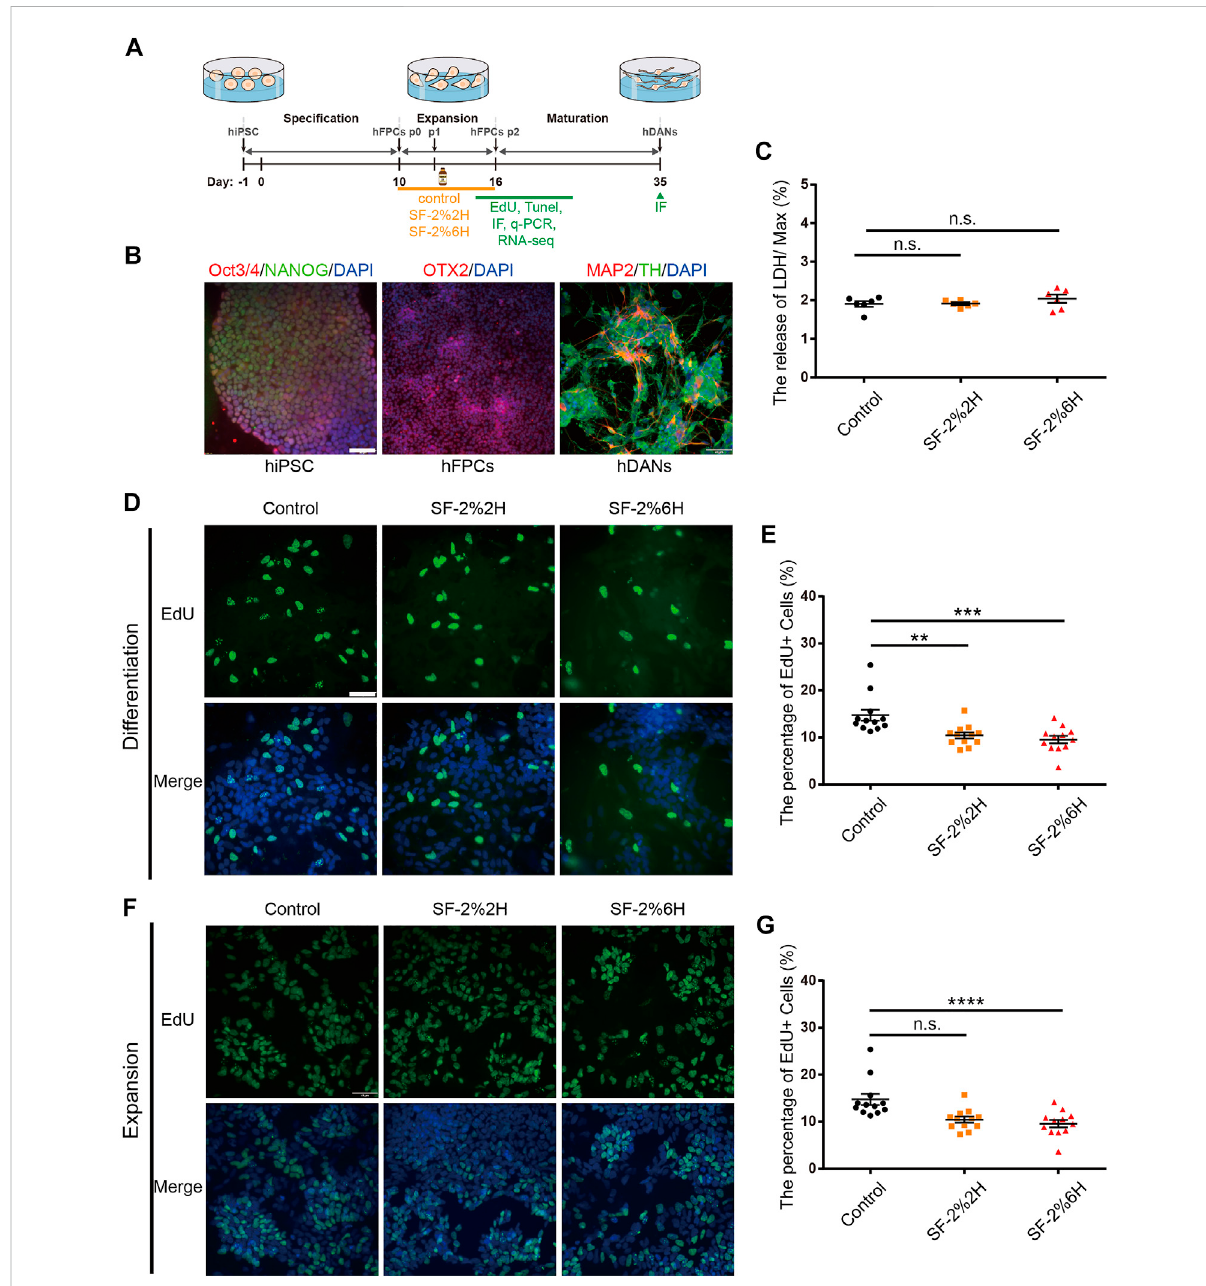
FIGURE 1 Sevo fl urane decreased the proliferation of monolayer hFPCs. (A) Schematic representation of the experimental pipeline used in the differentiation process of hiPSCs-derived hDANs. (B) Con fi rmation of the expressions of hiPSCs, hiPSCs-derived hFPCs, and hFPCs-derived hDANs. Immunolabeling of Oct4 (red), Nanog (green) and DAPI (blue) in hiPSCs; OTX2 (red) in hiPSCs-derived hFPCs on D10. hFPCs were further differentiated into hDANs, as illustrated using MAP2 (red) and TH (green) on D35. (C) LDH relative release of hFPCs in the control, SF-2%2H and SF-2%6Hgroups. (D – G) RepresentativeimageofEdUstaining(green)withDAPI(blue)counterstainduringbothdifferentiation (D) andexpansion (F) . (E) Quanti fi cationof (D) . (G) Quanti fi cationof (F) .SampleimagesofhFPCsweretakenusinganOlympusmicroscopeIX83 (D,F) .Scalebarsrepresent 50 μ m. Data represent mean ± SEM ( n =